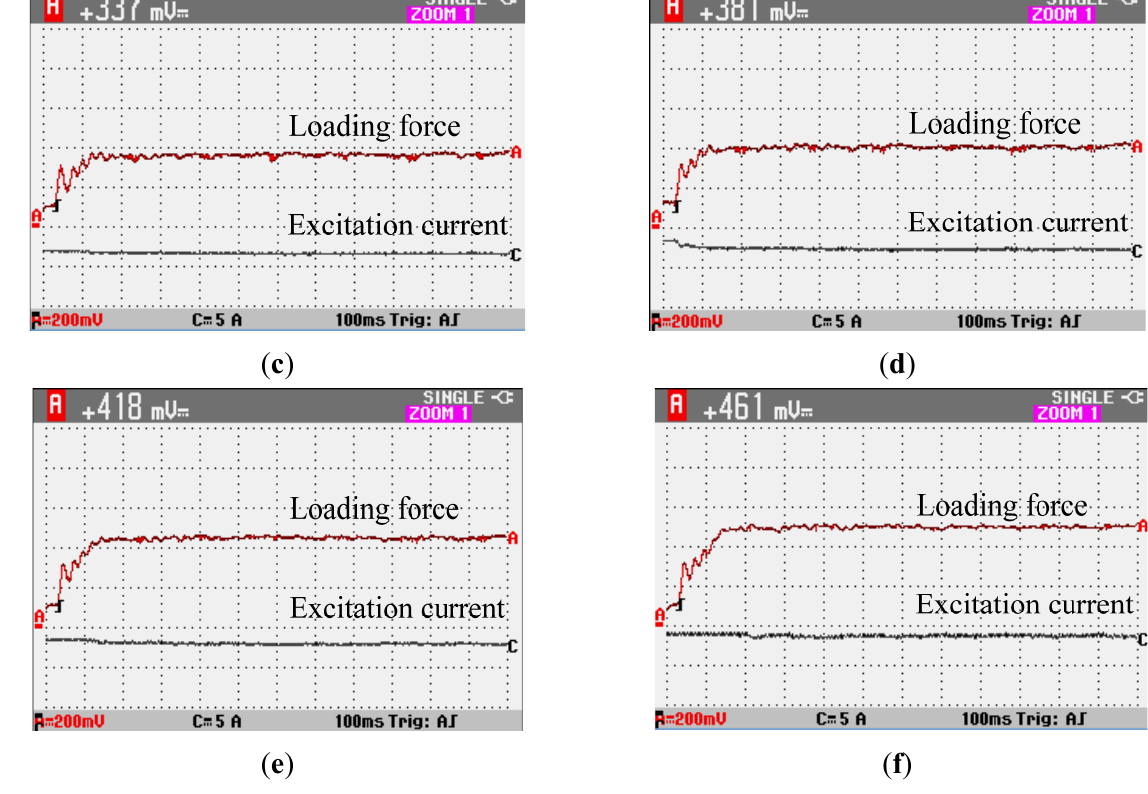
Figure 21. ( a ) Output current with the two-level PWM schemes; ( b ) output current with the three-level PWM scheme; ( c ) F ref = 70 N; ( d ) F ref = 80 N; ( e ) F ref = 90 N and ( f ) F ref = 100 N.